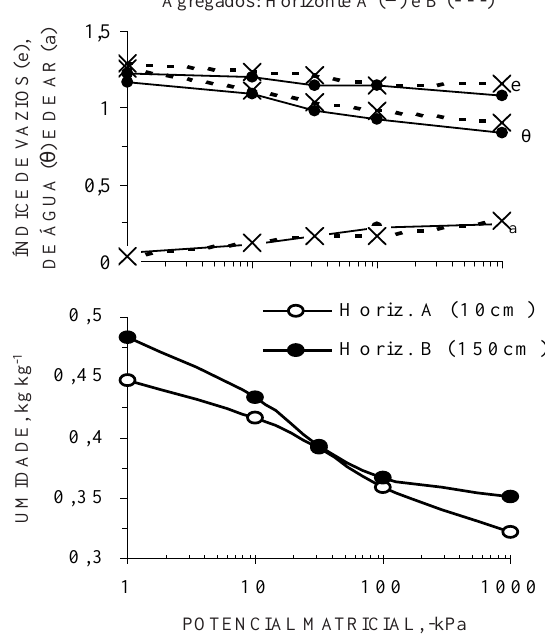
Figura 2. Índices de vazios (e), de água (q) e de ar (a) e curva característica de umidade dos agregados de 2 a 3 mm de diâmetro, dos horizontes A e B do Latossolo Amarelo sob floresta amazônica.